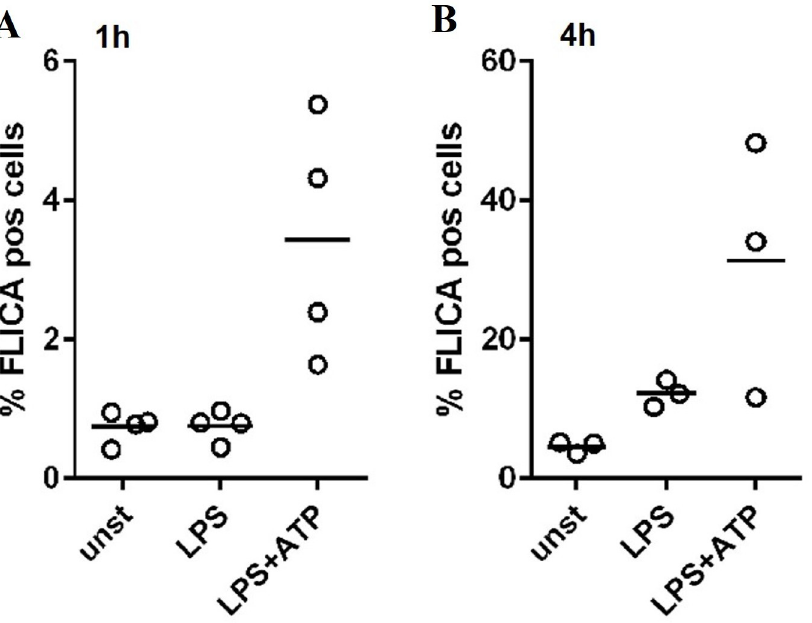
Fig 5. Caspase activation in whole blood assay. FAM-YVAD-FMK (FLICA) binding to active caspase-1 in monocytes after 1h (A) and 3h stimulation (B). Data are expressed as % of FLICA + cells in whole blood, n = 4 (A) and n = 3